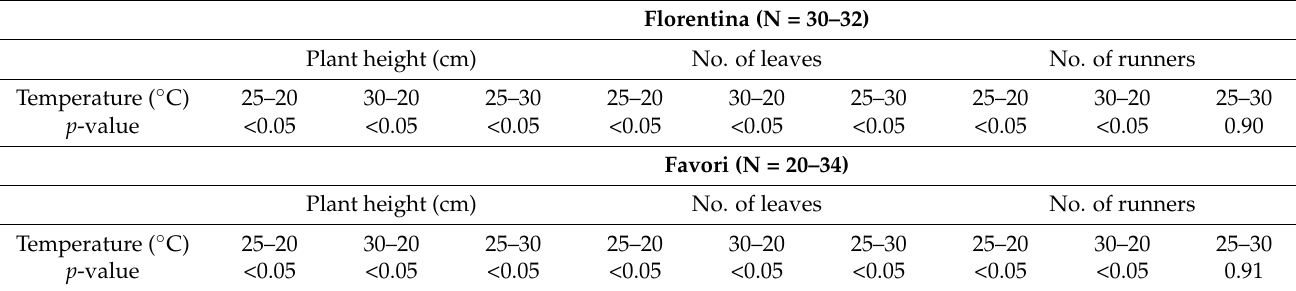
Table 3. Pairwise comparison using least square means for plant height, number of leaves and runners between the temperature treatments for the cultivars ‘Florentina’ and ‘Favori’. The p -value was adjusted using the Tukey-pairwise correction method ( p = 0.05).